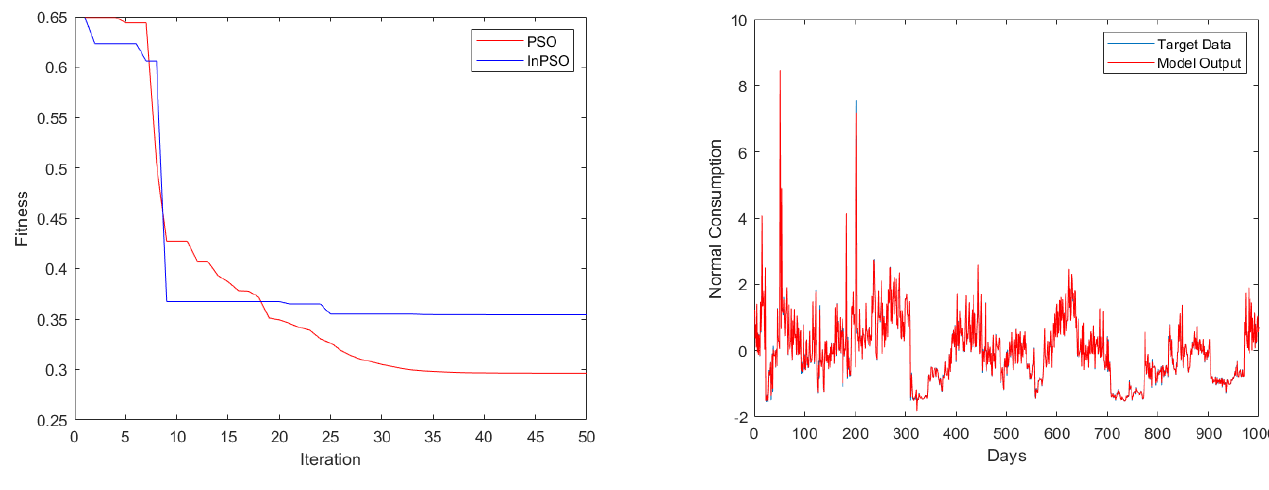
Figure 4. The results of the DNFW prediction for Mashhad’s energy consumption.